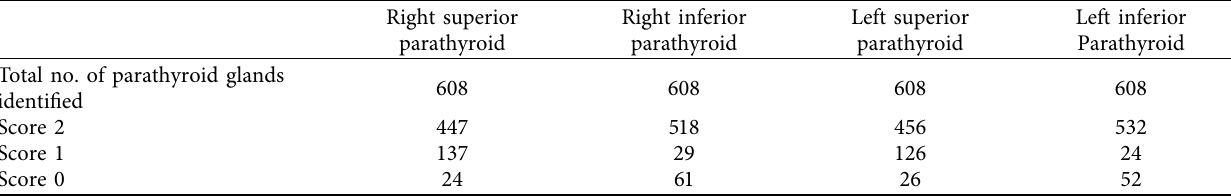
Fine-needle pricking (FNP) score: FNP 0, the parathyroid has no blood oozing after the pricking, indicating the gland is not vascularized; FNP 2, the parathyroid has blood effusing out after the pricking, indicating that the gland is well vascularized; FNP 1, the parathyroid has blood oozing, but it is slow and small, and the slow blood oozing persist when it was wiped by gauze, suggesting that the gland is partially